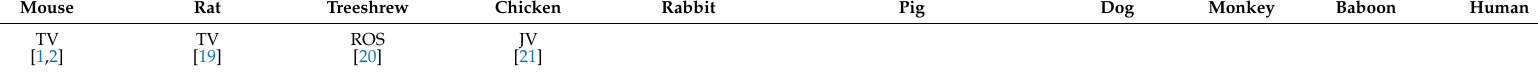
Table 1. Animals, target organs, and routes for which hydrodynamic delivery has been